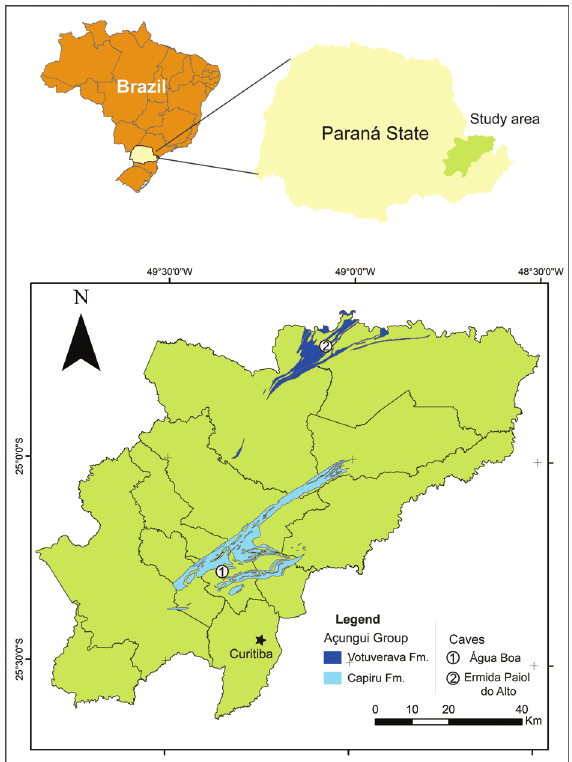
Figure 1 . Map of Açungui karst locating the Votuverava and Capiru formations. Numbers indicate cave position. Legend: Fm =